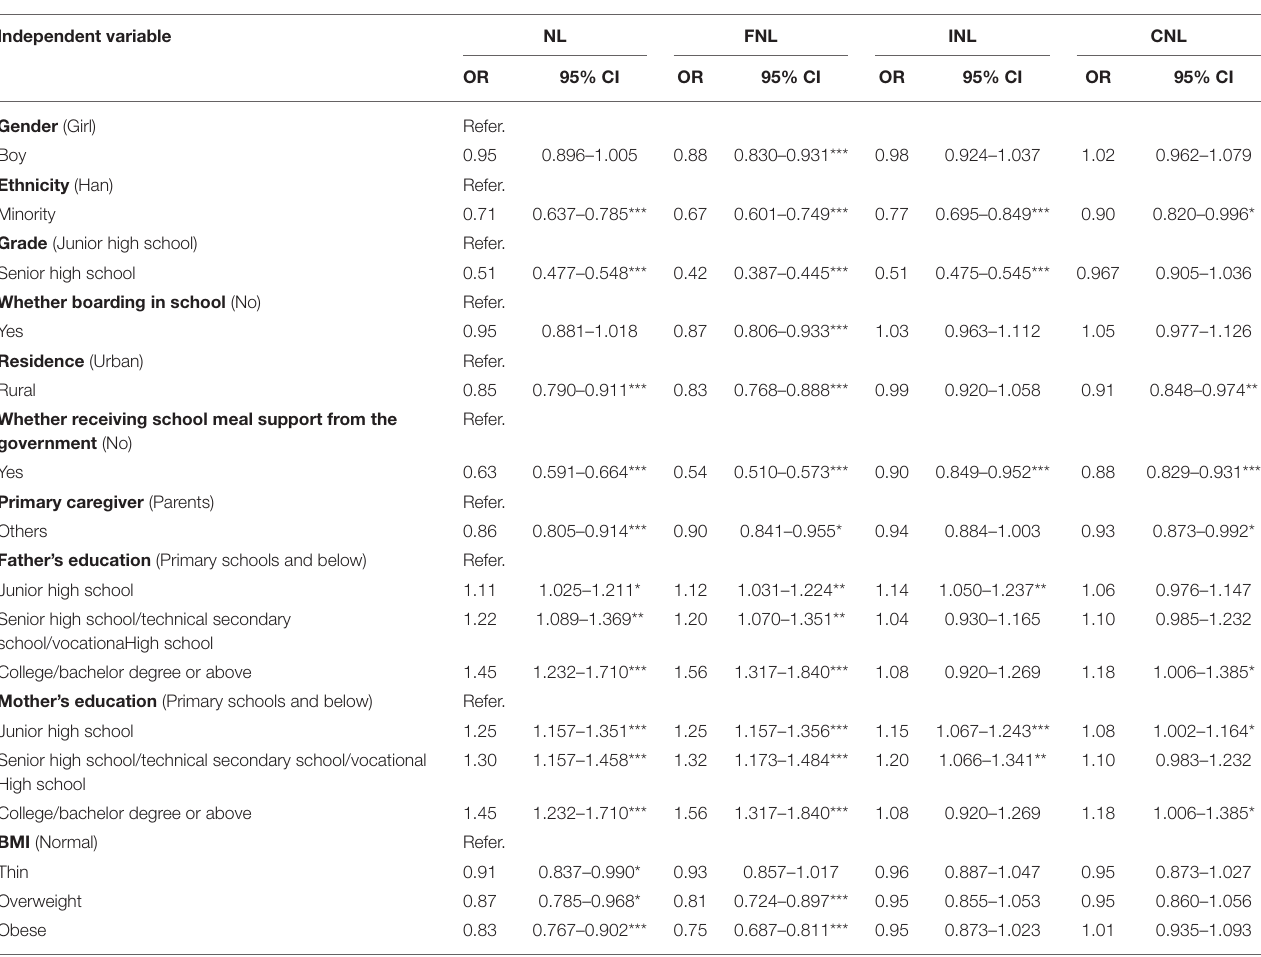
TABLE 3 | Binary logistic regression for nutrition literacy of participants. Independent